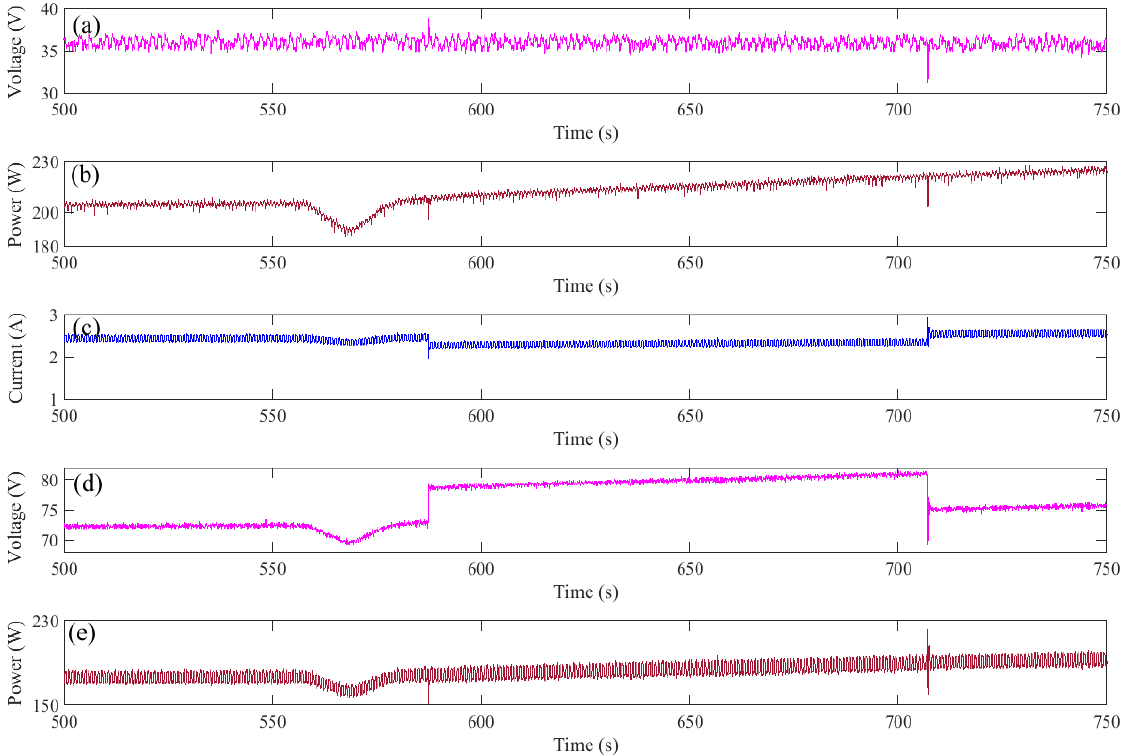
Figure 15. MPPT based on P&O: ( a ) PV voltage; ( b ) PV power; ( c ) Boost converter output current; ( d ) Boost converter output voltage; ( e ) Boost converter output